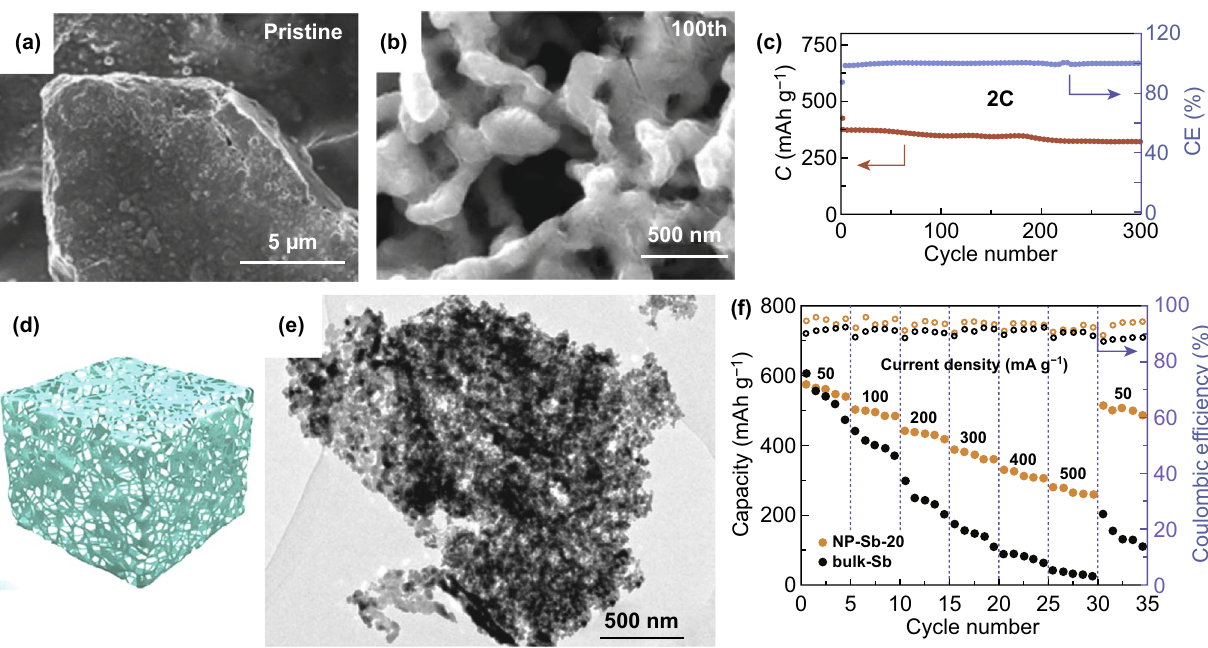
Fig. 14 SEM image of a pristine Bi and b Bi after 100th cycle. c Cycle performance of Bi electrode (1 C = 384.7 mAh g −1 ). Reproduced with permission from Ref. [229]. Copyright 2018, John Wiley and Sons. d Schematic illustration of NP-Sb. e TEM image of NP-Sb-20. d Rate per- formance of two samples in the range of 50–500 mA g −1 . Reproduced with permission from Ref. [72]. Copyright 2018, American